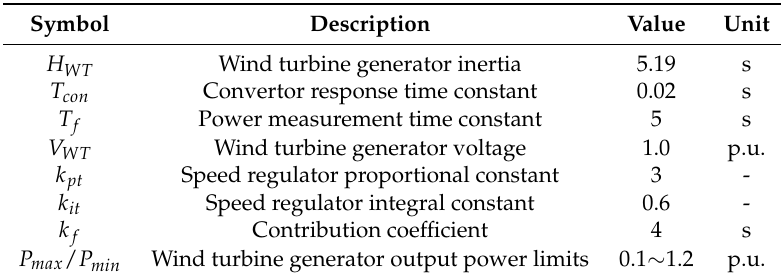
Figure 3. Variable-Speed Wind Turbine Model with Supplementary Control Loop. Table 3. WTG model parameters used for